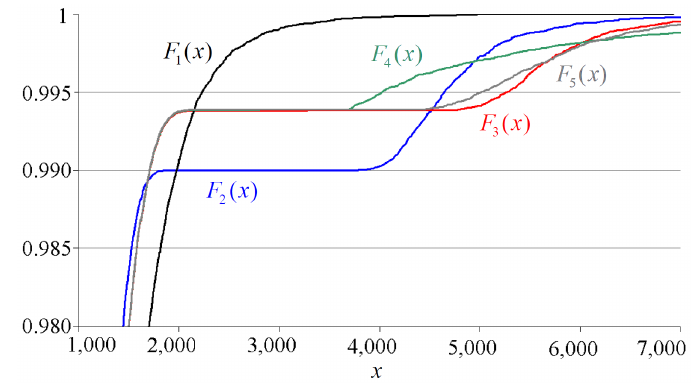
Figure 15: Plots of the estimated cdf’s F i ( x ) , i = 1, . . . , 5 , in the tail.